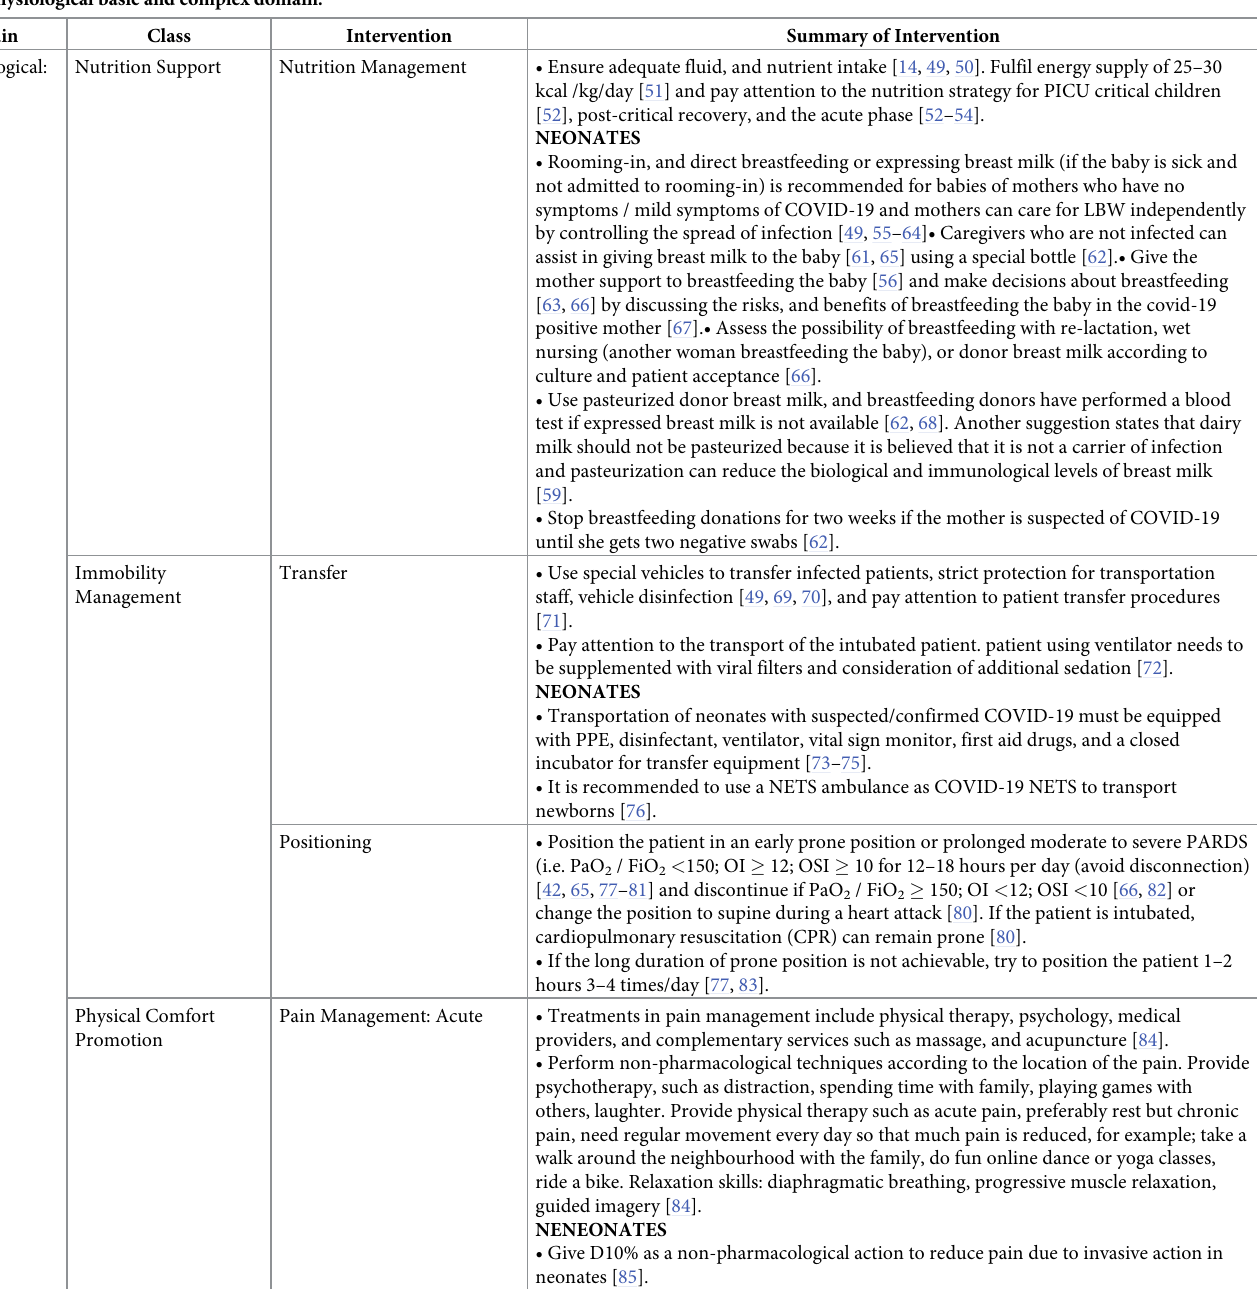
Table 1. Physiological basic and complex